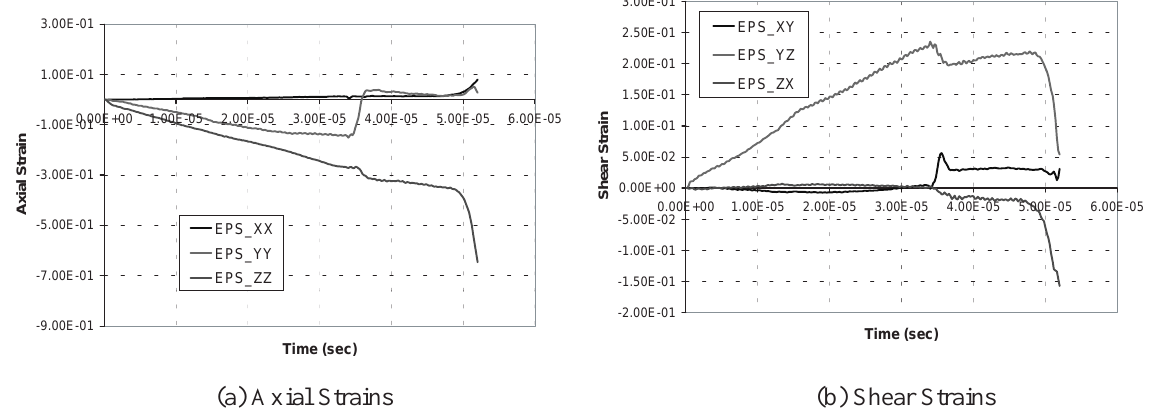
(a) Axial Strains (b) Shear Strains Fig. 9. Time histories of strain components in element 2184: (a) axial strains; and (b) shear